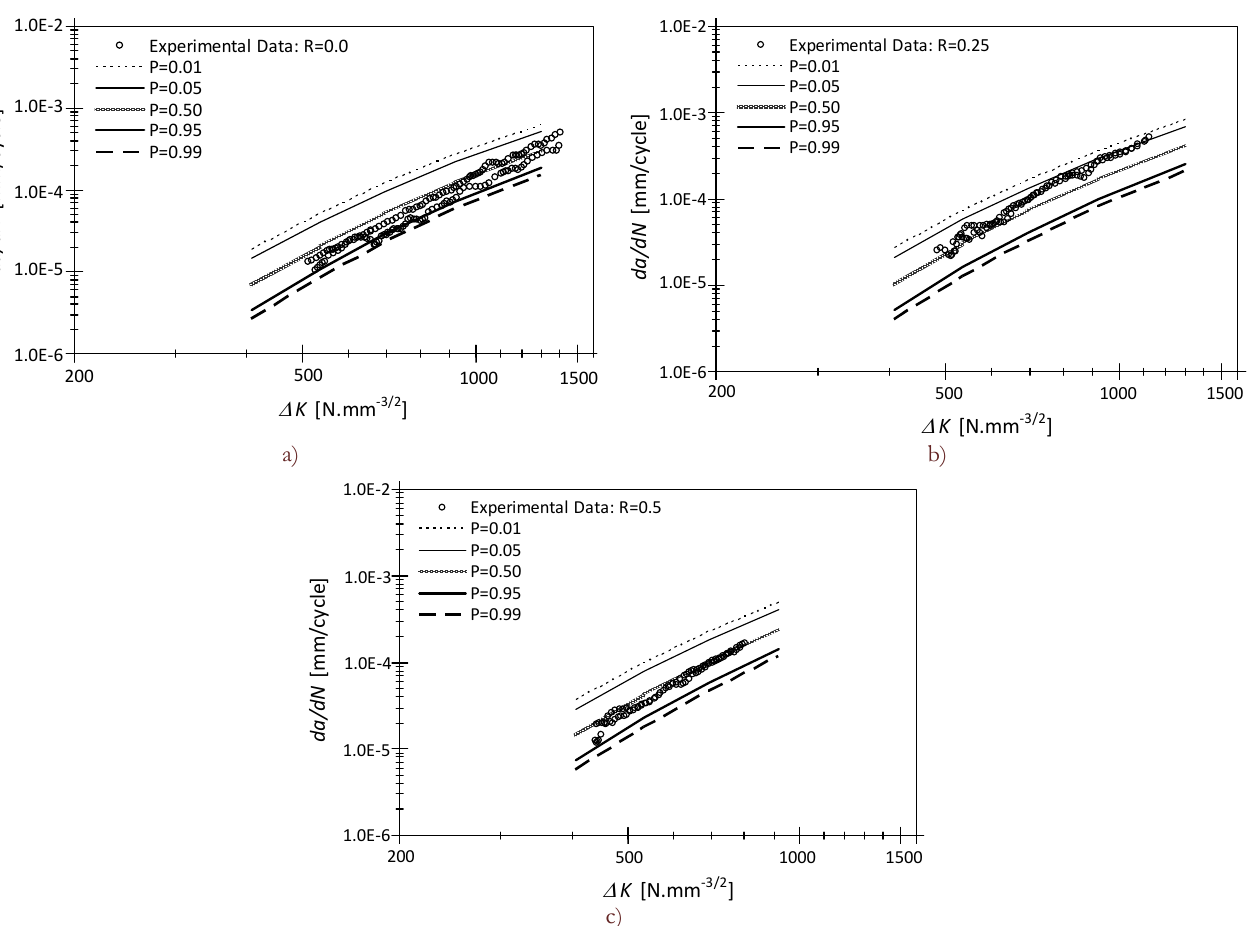
Figure 17: Probabilistic prediction of the fatigue crack propagation based the p-SWT-N field, for the S355 steel: a) R R σ